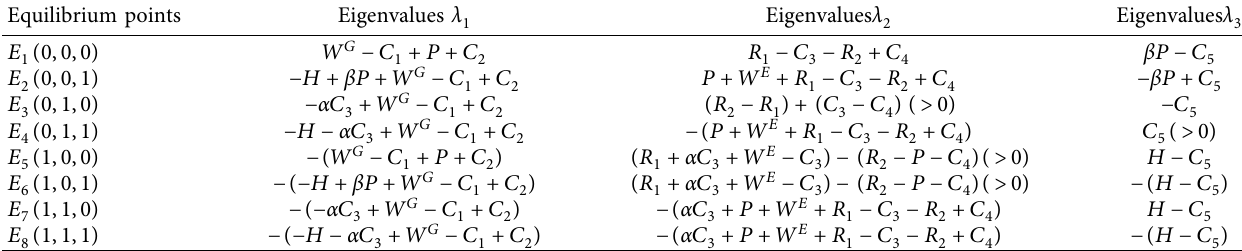
Table 3: Eigenvalues of the Jacobian matrix.